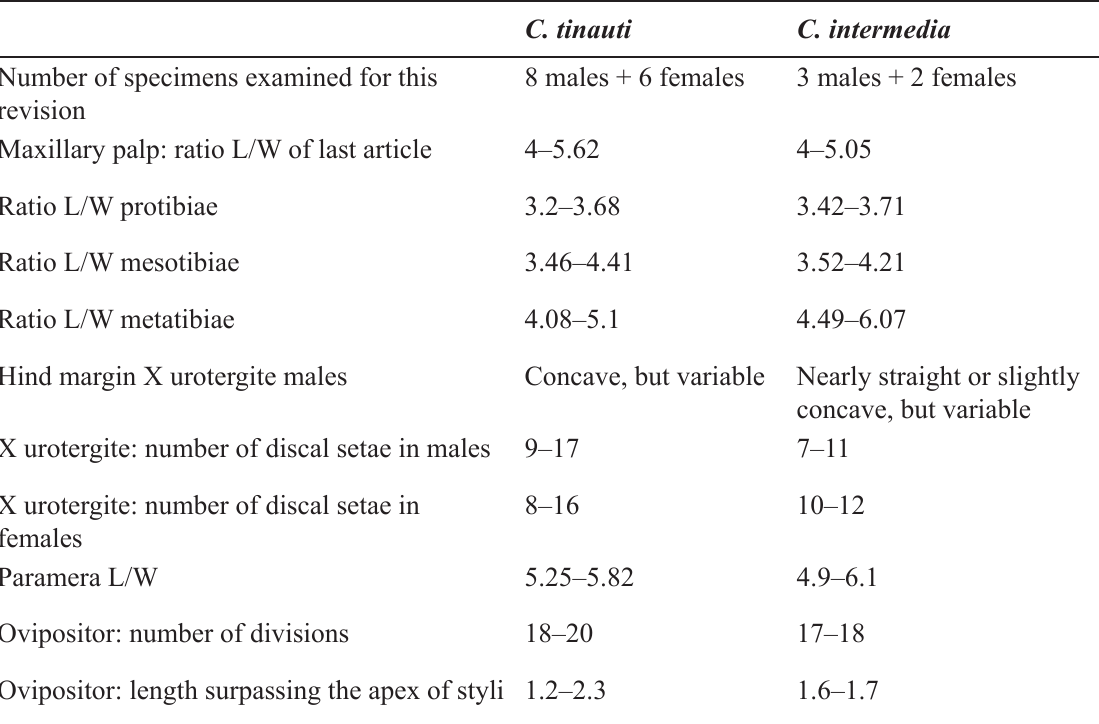
Table 1. Overlapping of variability in some characters of specimens identified as Coletinia tinauti Molero, Gaju & Bach, 1997 and C. intermedia Molero, Bach & Gaju, 2013. Only characters are included that, after the evaluation of additional specimens or re-examination of previously studied material, modify their range of variability respect to those provided by Molero et al. (2013). Abbreviation: L/W = ratio length /